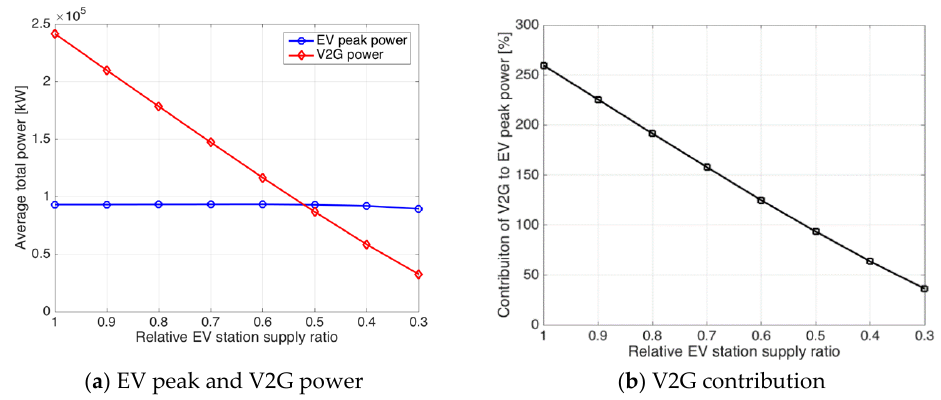
Figure 9. Change of EV peak and V2G power and V2G contribution when relative EV supply ratio is reduced from 1 to 0.3.